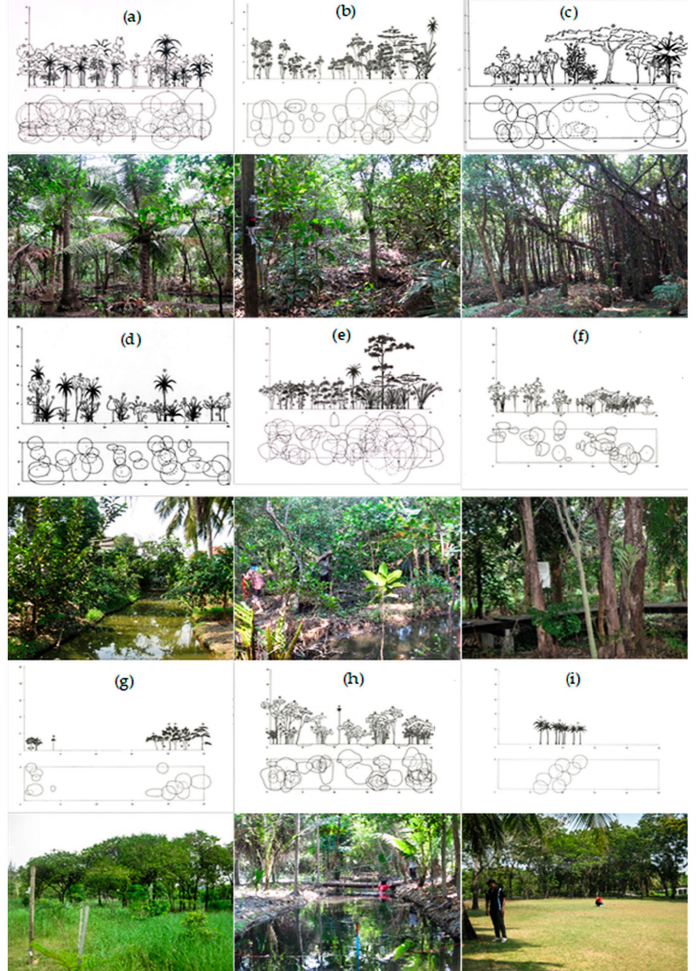
Figure 3. Appearance of vegetation from ground and plan views of study plots in Bang Kachao Green Space, Bangkok, Thailand. Plot descriptors are given in Table 1. Plots 1 ( a ); 2 ( b ); 3 ( c ) and 6 ( f ) were rehabilitation forest, plots 4 ( d ) and 8 ( h ) were home-garden agroforestry, plot 5 ( e ) was mangrove forest, plot 7 ( g ) was in Chalerm Phra Kiat the King Bhumibhol 80 Phansa Park, and plot 9 ( i ) was in Sri Nakhon Khuean Khan Park and Botanical